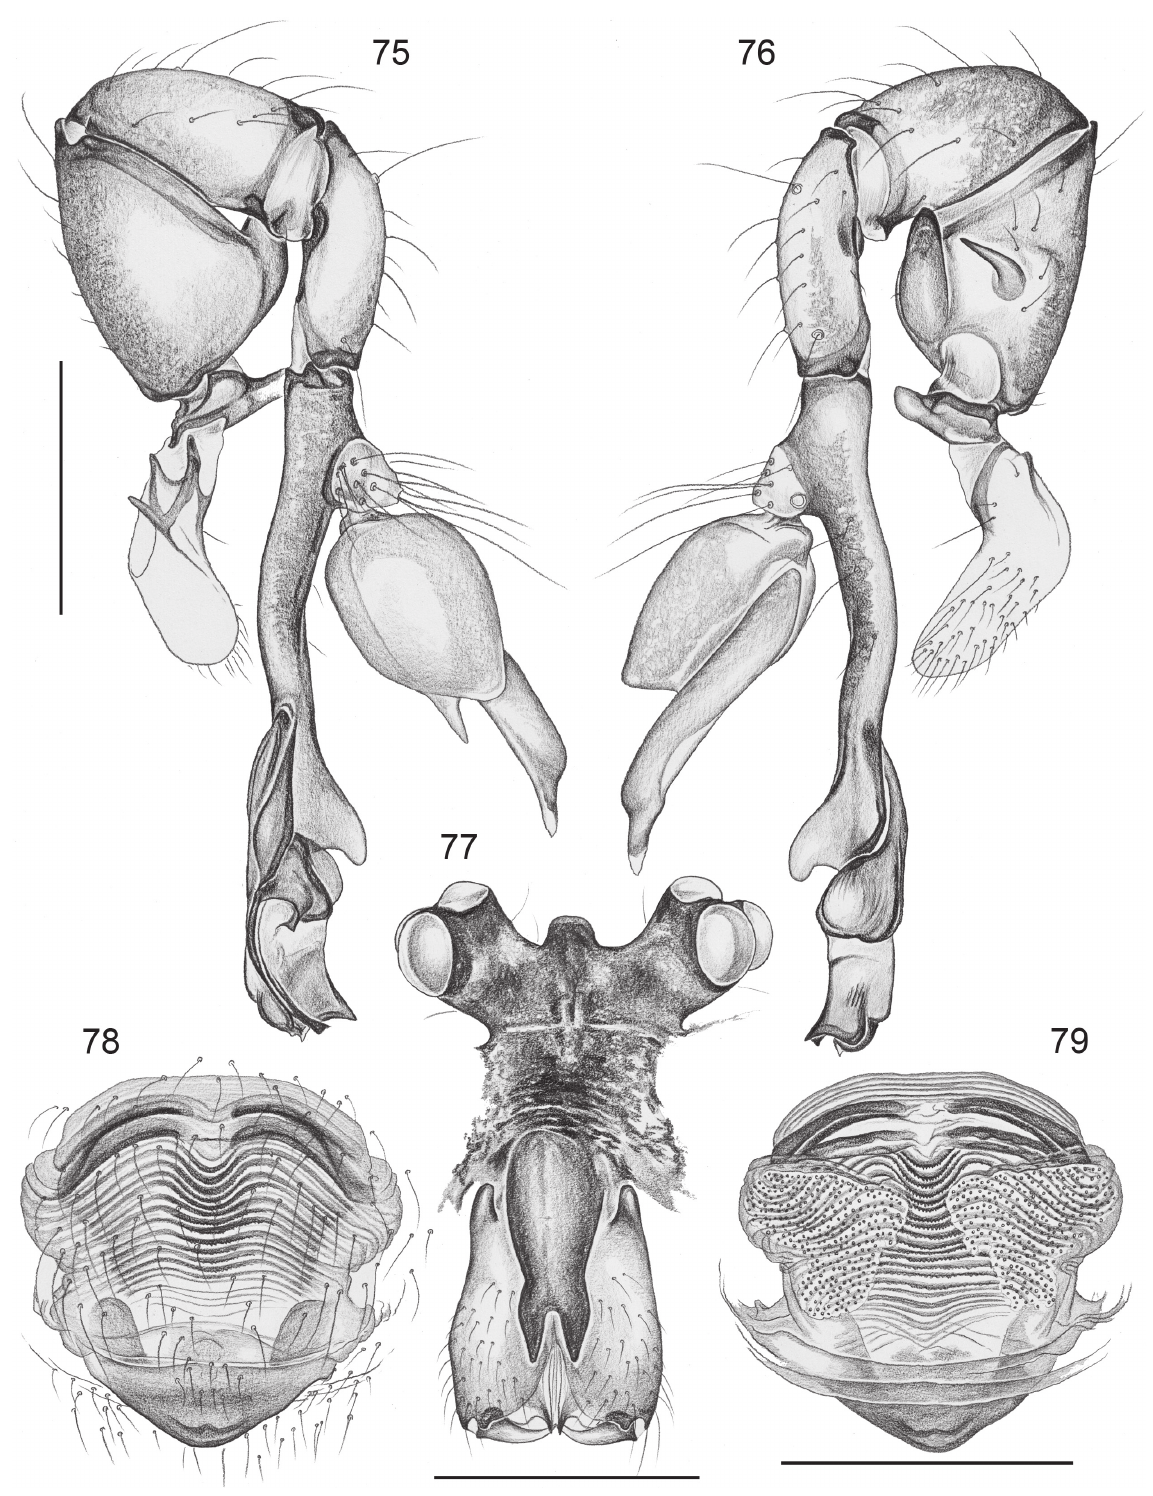
Figs 75–79. Aetana loboc Hube r, sp. nov. 75–76 . Left male palp, prolateral and retrolateral views. 77 . Male prosoma, frontal view. 78–79 . Cleared female genitalia, ventral and dorsal views. Scale lines: 0.5